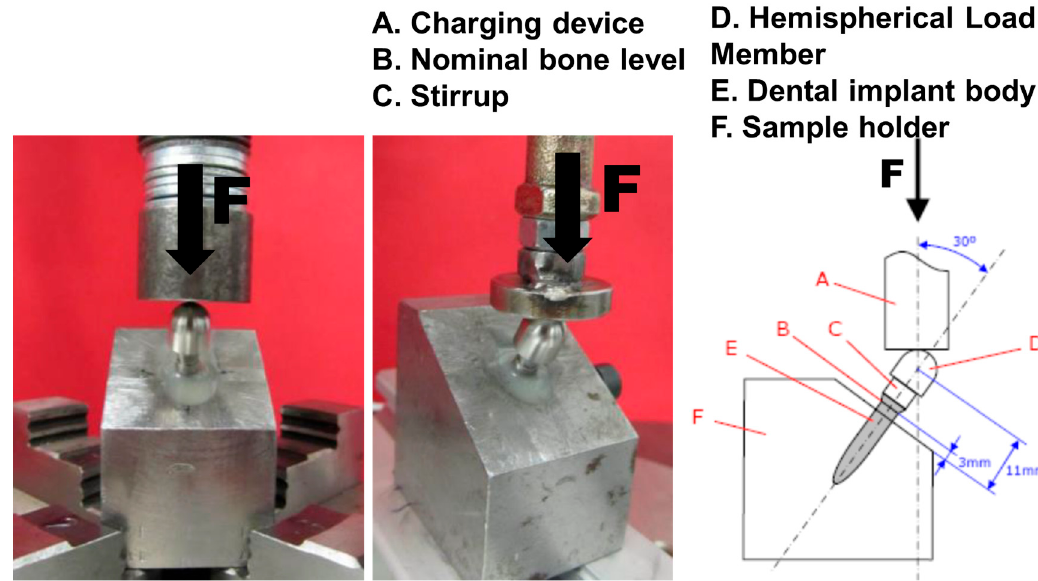
Figure 9. Dental implant in the experimental setting.